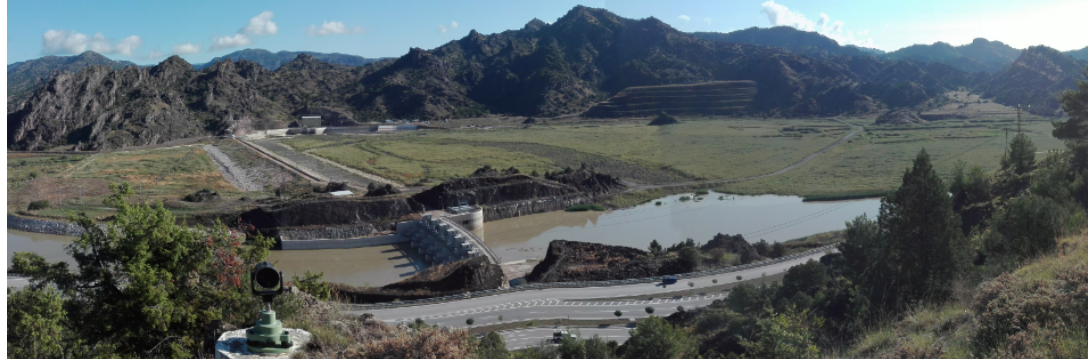
Figure 1. Discharged dam with the inlet structures and mountain range crossed by the headrace tunnel.